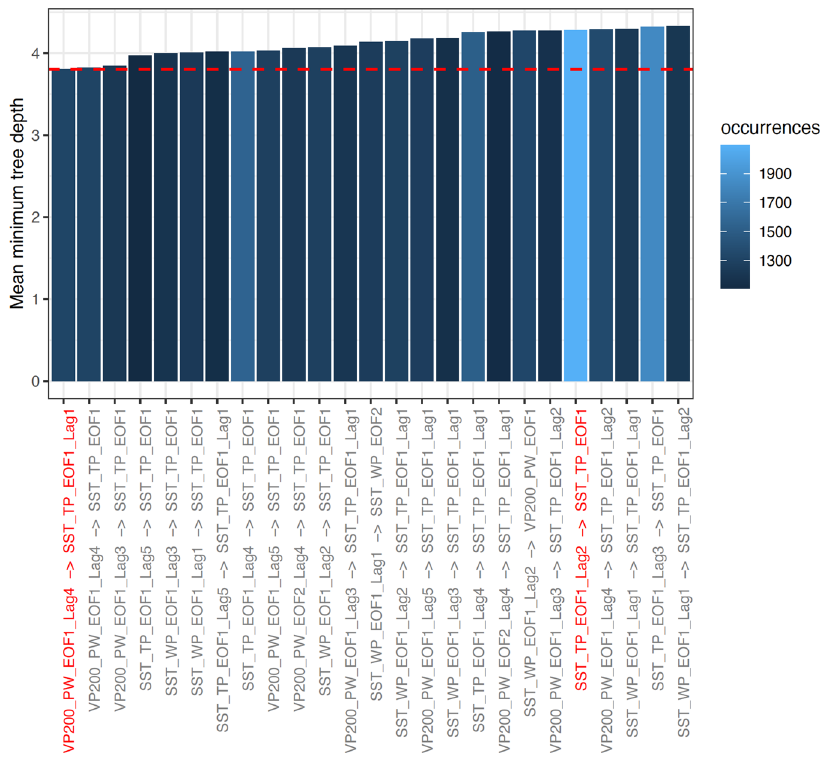
Fig. 6 Most important variable interactions for the Random Forest model. Mean minimum tree depth for the top-25 pairwise variable interactions for the Random Forest model predicting JFM clusters. The variable interactions shown are the shallowest of all possible variable interactions, suggesting overall higher importance for in fl uencing the probability of a prediction. Of these interactions, the shallowest and most frequent pairwise interactions are highlighted in